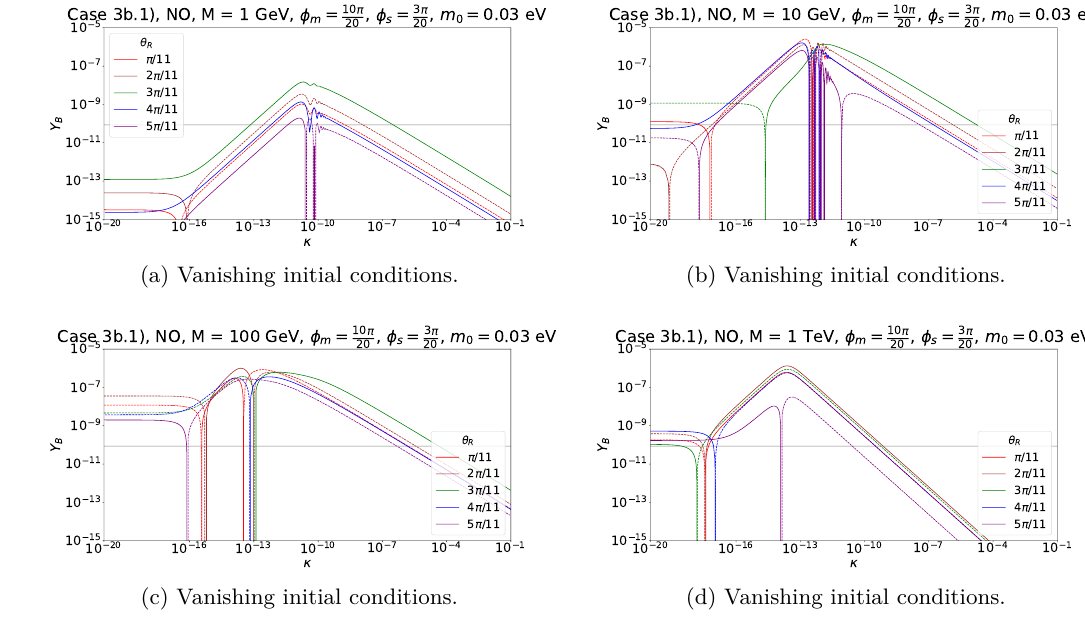
Figure 37 . Case 3 b.1) Y B as function of κ for a Majorana mass M = 1 GeV (upper left plot), M = 10 GeV (upper right plot), M = 100 GeV (lower left plot) and M = 1 TeV (lower right plot). For each of these choices, different values of θ have been considered. The group theory parameters R are fixed to n = 20 , m = 10 and s = 3 . Light neutrino masses have NO with m = 0 . 03 eV. For the 0 rest of the choices see figure 22.